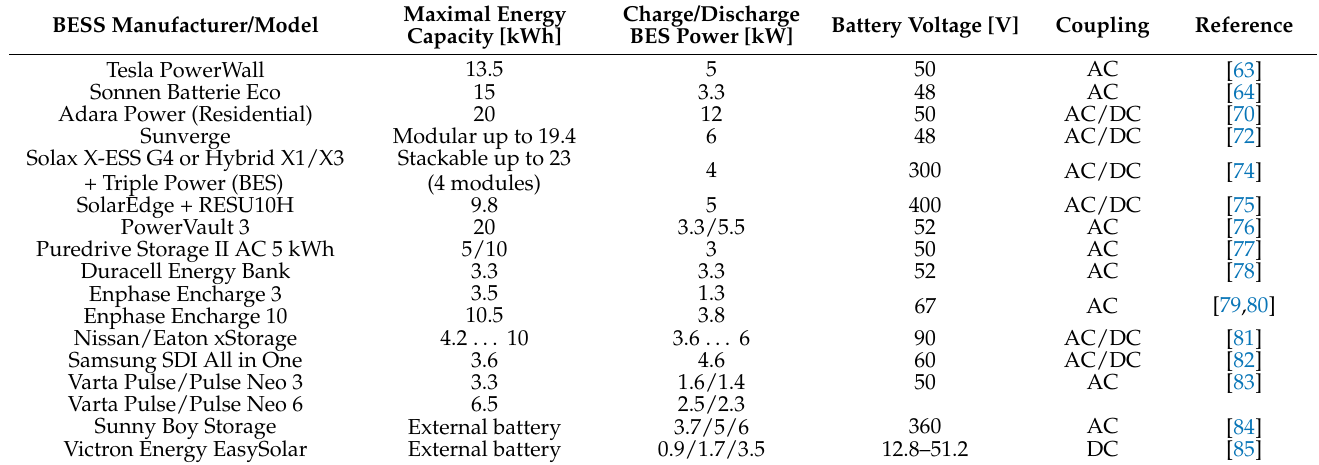
Table 2. Summary of BESS for general use and use with renewable energy sources available on the market.